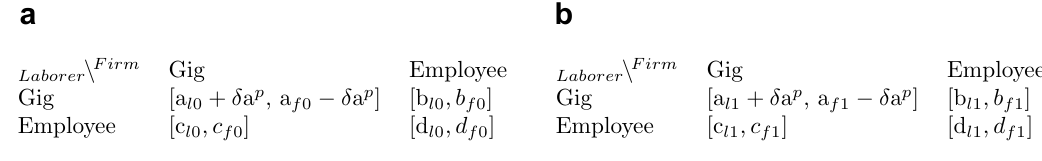
Figure 5: High Gig Payo↵, Matrix Operation